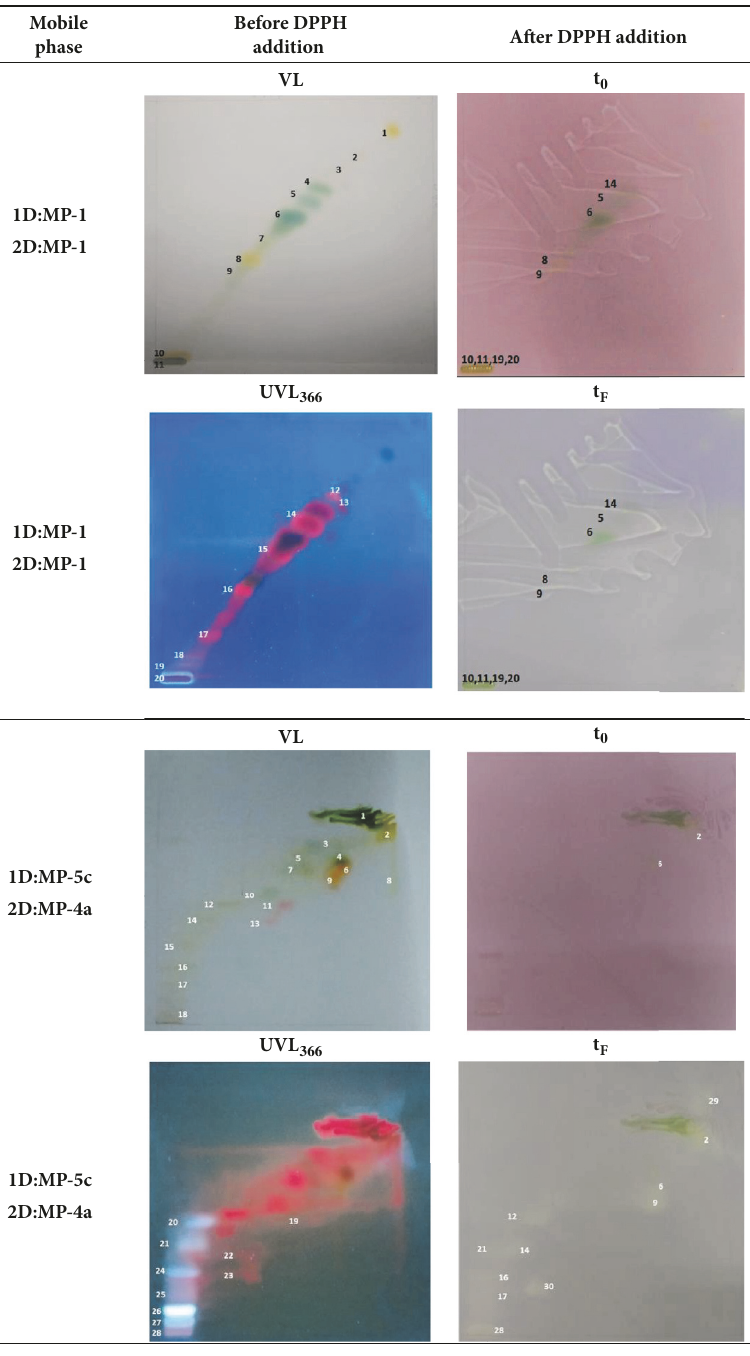
Figure 2: Representative photographs of 2D thin layer chromatograms for a methanolic extract of Spirulina platensis , developed with the indicated mobile phases and visualized under visible light (VL) and under ultraviolet light (UVL 366 ) (central column) and the correspondent 2D thin layer biochromatograms, obtained after DPPH treatment at t 0 and t F (right